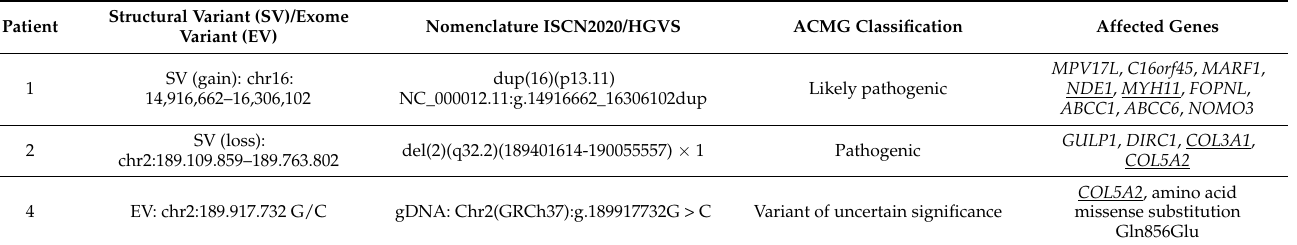
Table 2. Genetic findings. Copy number variants were detected in three patients. Underlined genes are ohnolog